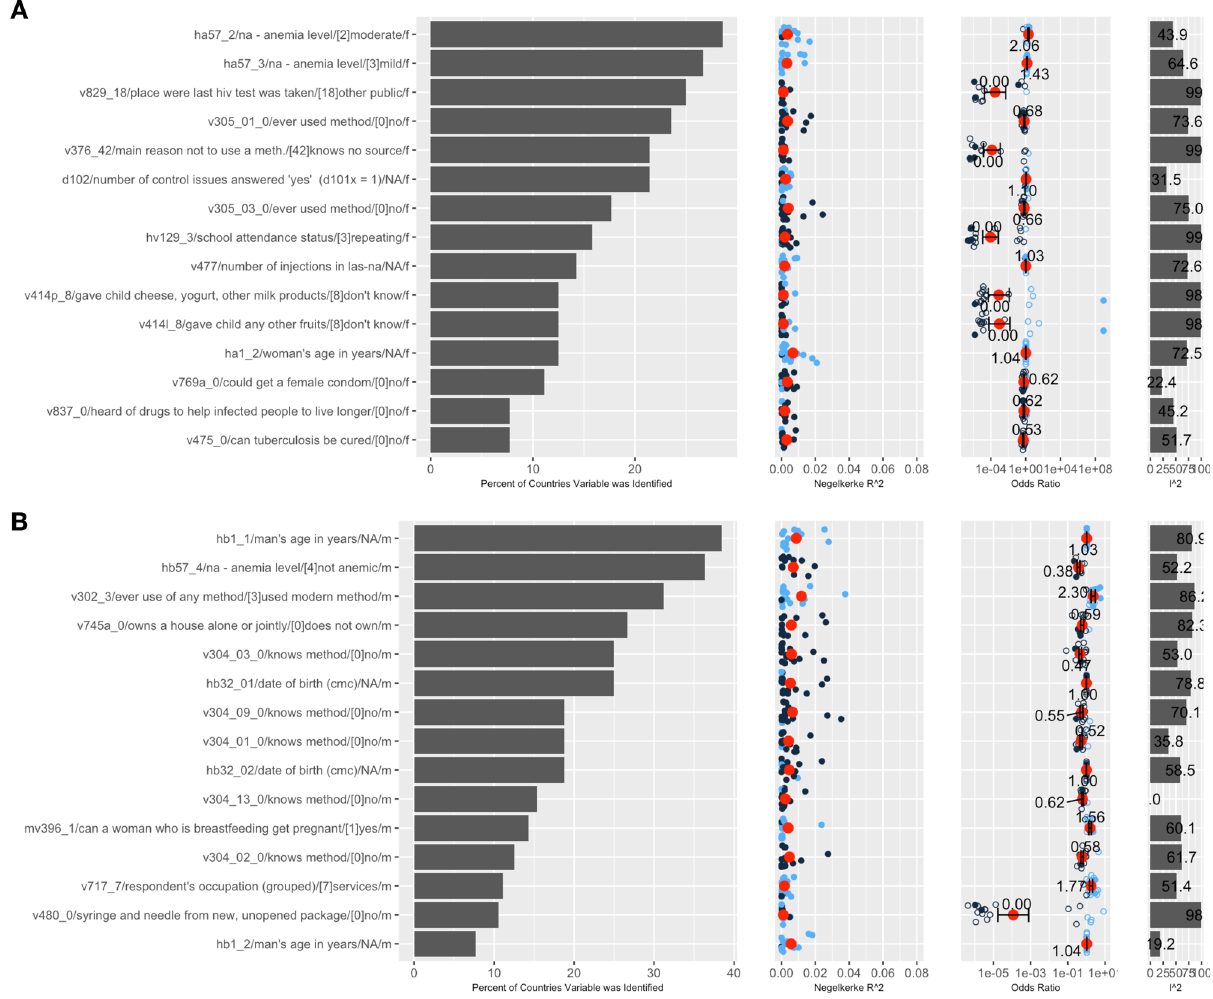
Fig. 3 Top 15 variables identi fi ed across 11 – 20 countries. A Top 15 variables in females and B Top 15 variables in males. Left most panel is the variable name and code name, 2nd panel from left is the percent of countries variable was identi fi ed, 3rd panel from left is the Nagelkerke R2 per country (red dot is the average; blue points are countries with OR > 1, dark blue are countries with OR < 1), 4th panel shows the odds ratios (overall meta-analytic estimate in the red dot), and 5th panel shows the I2 (heterogeneity)). Error bars denote 2 times the standard error of the coef fi cient, which was estimated using a random-effects model. All data to reproduce fi gures, including the standard errors, can be found in Supplementary Data 2. The sample sizes (number of surveys) for the overall odds ratio (red) are in Supplementary Data